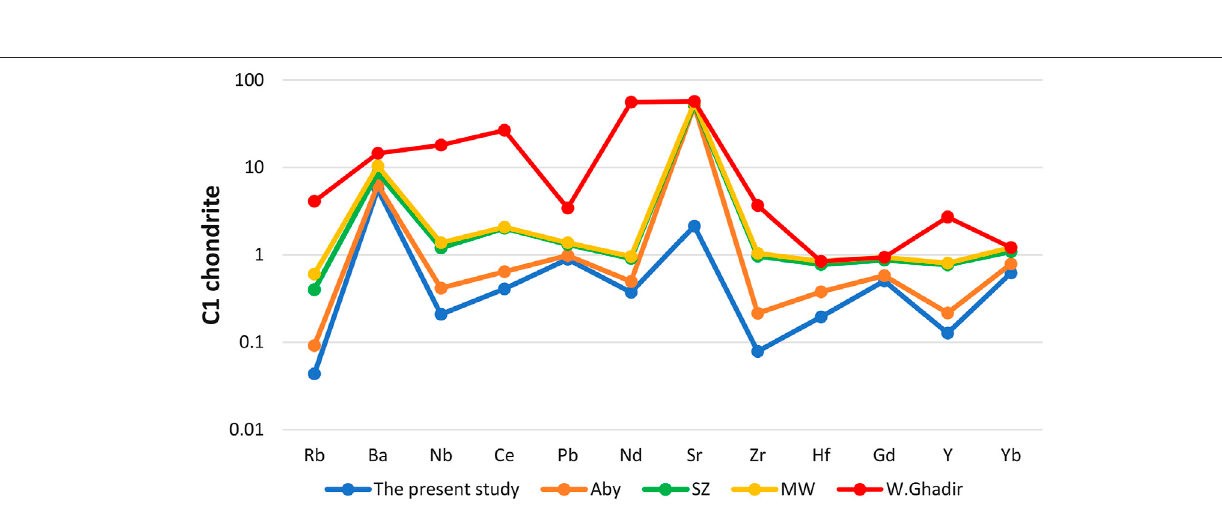
Frontiers in Earth Science |